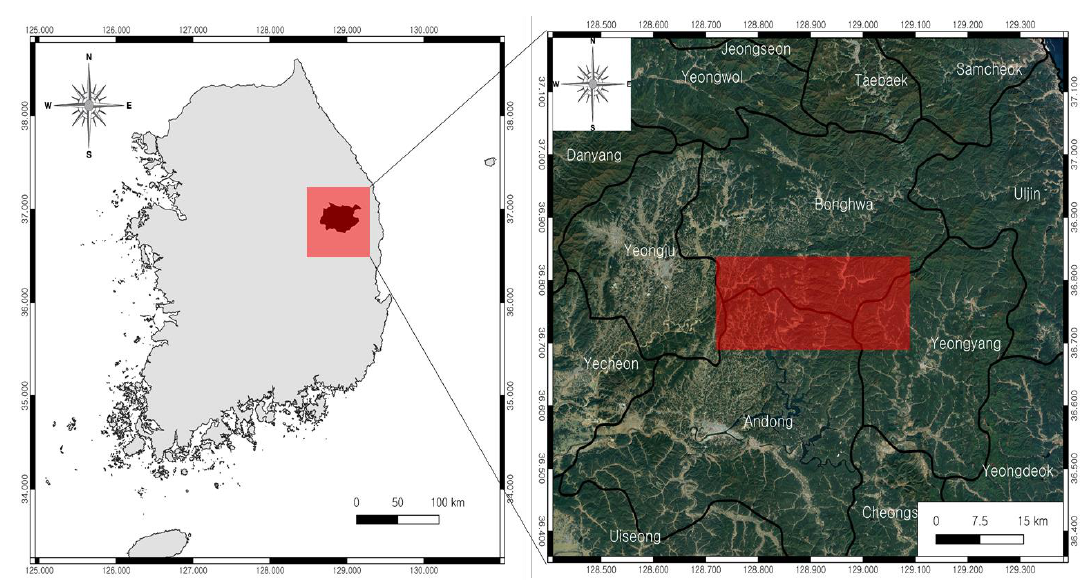
Figure 4. Study area in this study in the red box (Bonghwa-gun).